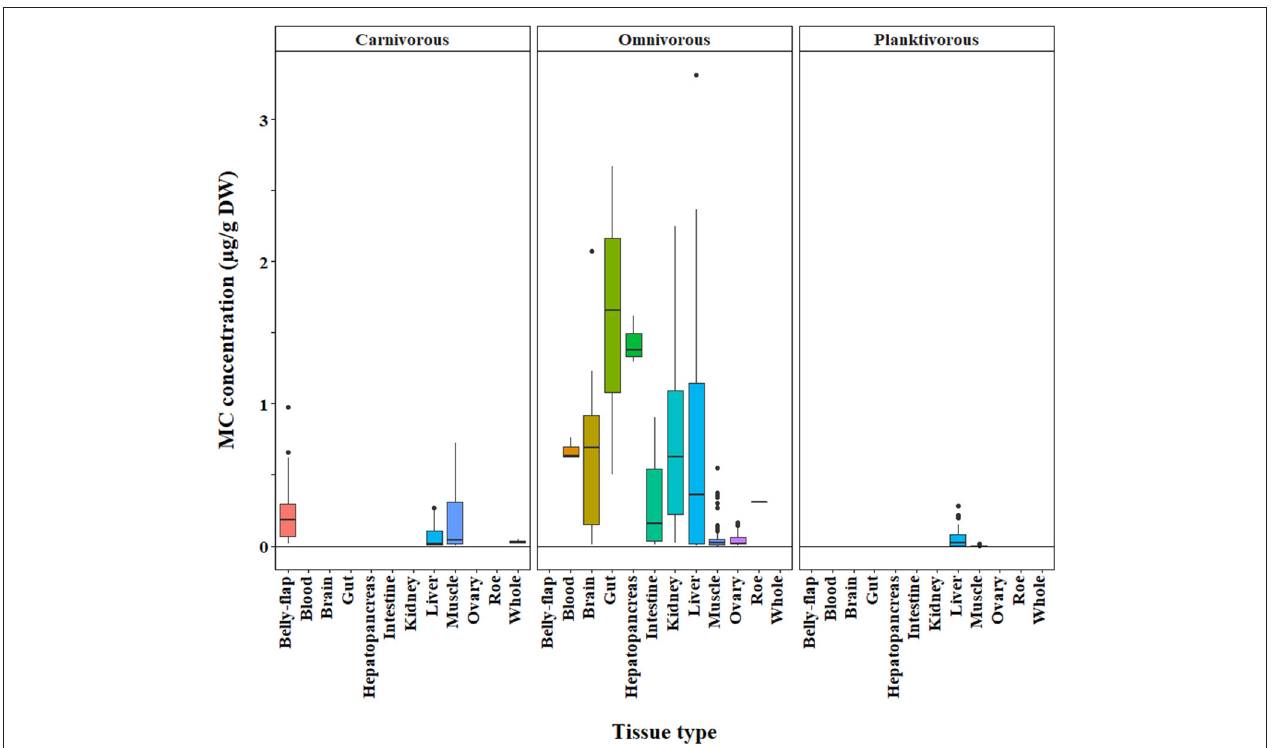
FIGURE 4 | Microcystin (MC) concentrations in fish grouped by trophic level (carnivore, omnivore, planktivore) across a range of tissue types. Concentrations were quantified by the ELISA method. The raw data are